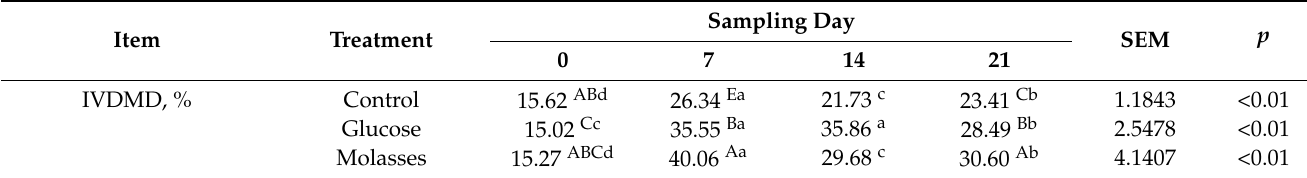
Table 6. In vitro fermentation parameters of rice